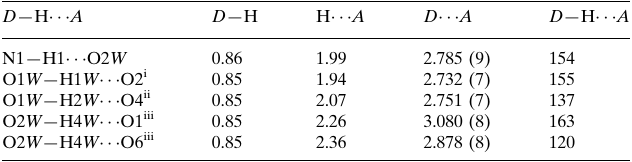
Data collection Bruker APEXII area-detector diffractometer Absorption correction: multi-scan ( APEX2 ; Bruker, 2004)